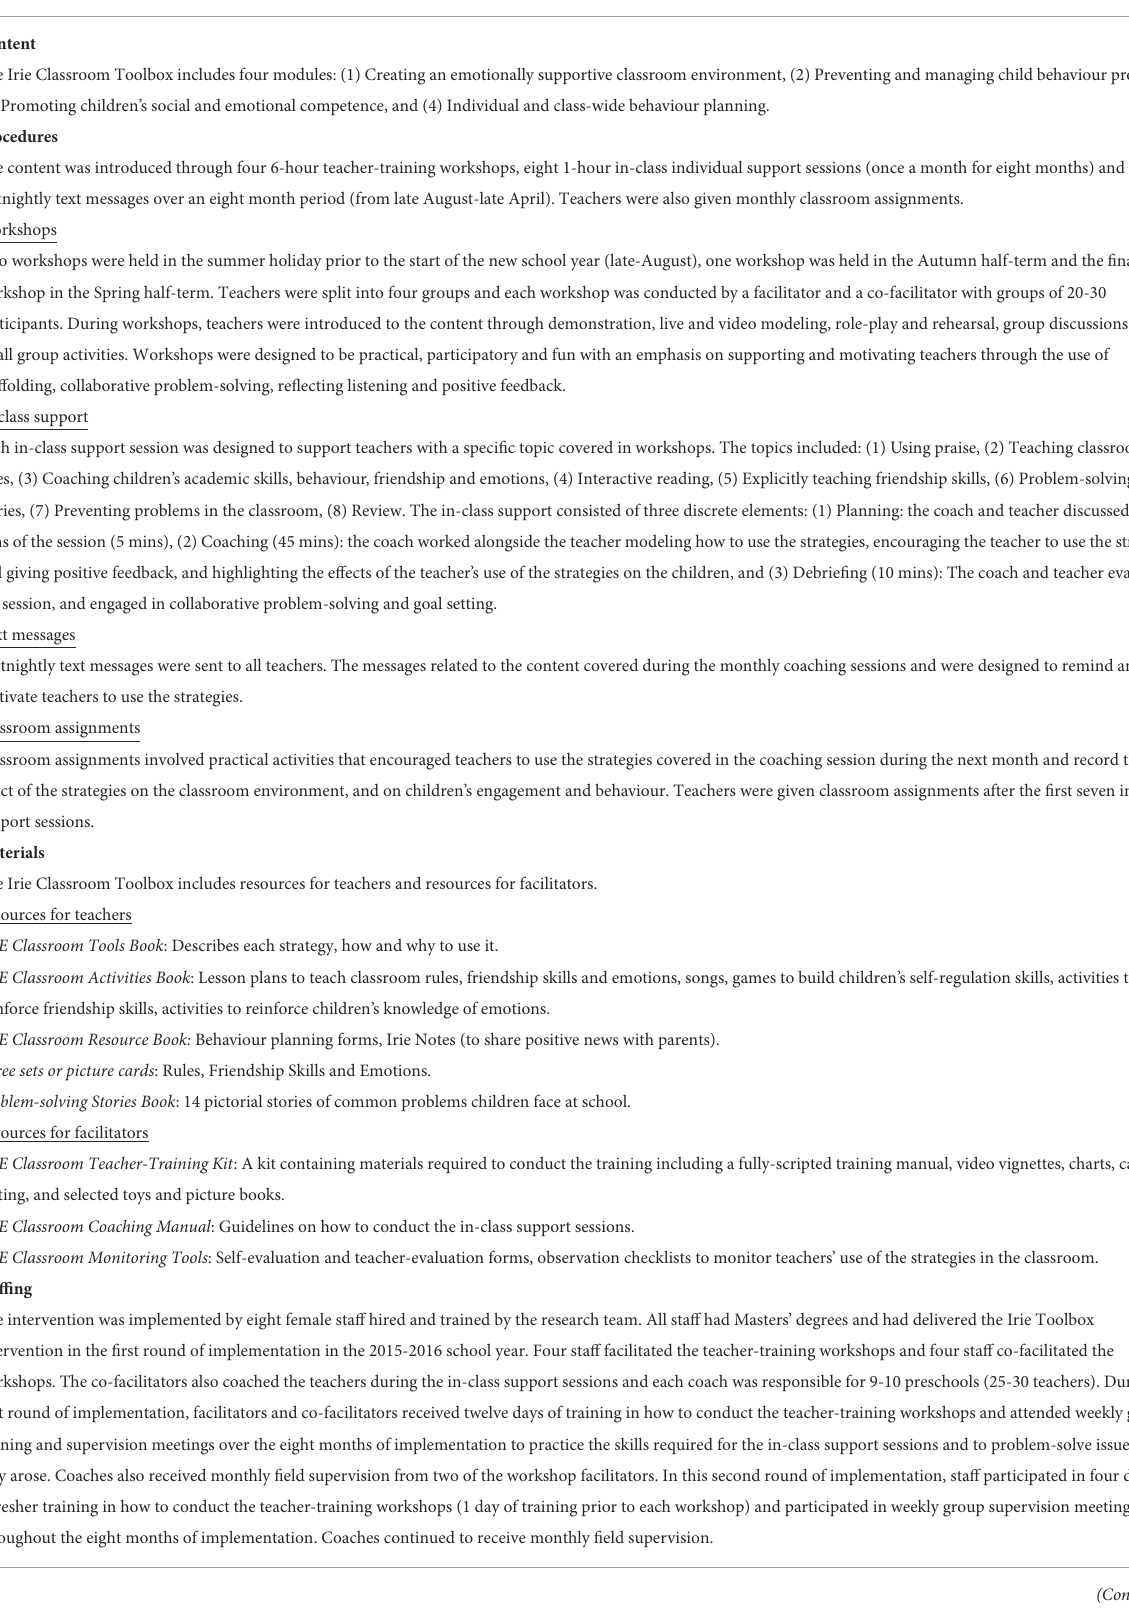
TABLE 1 The Irie Classroom Toolbox